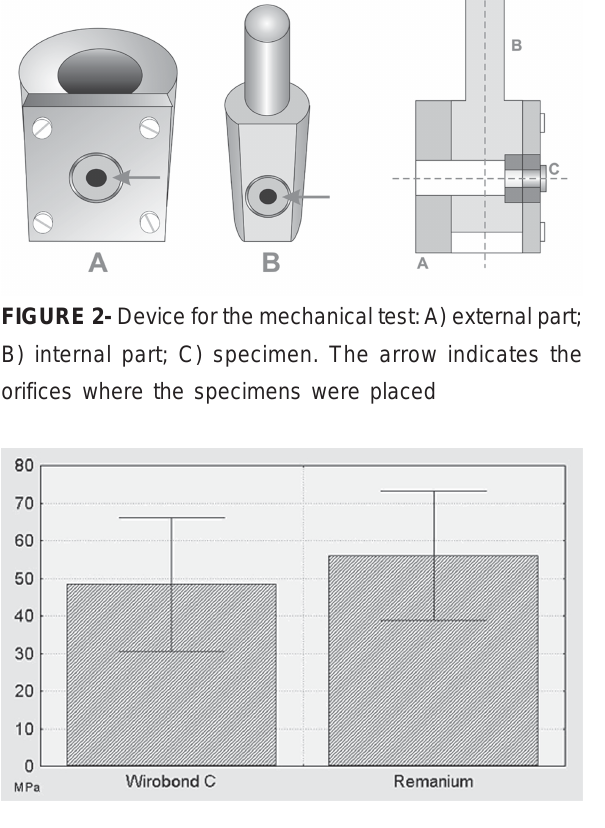
FIGURE 3- Graphic representation of the means and standard deviations of shear resistance data (MPa) according to the alloy